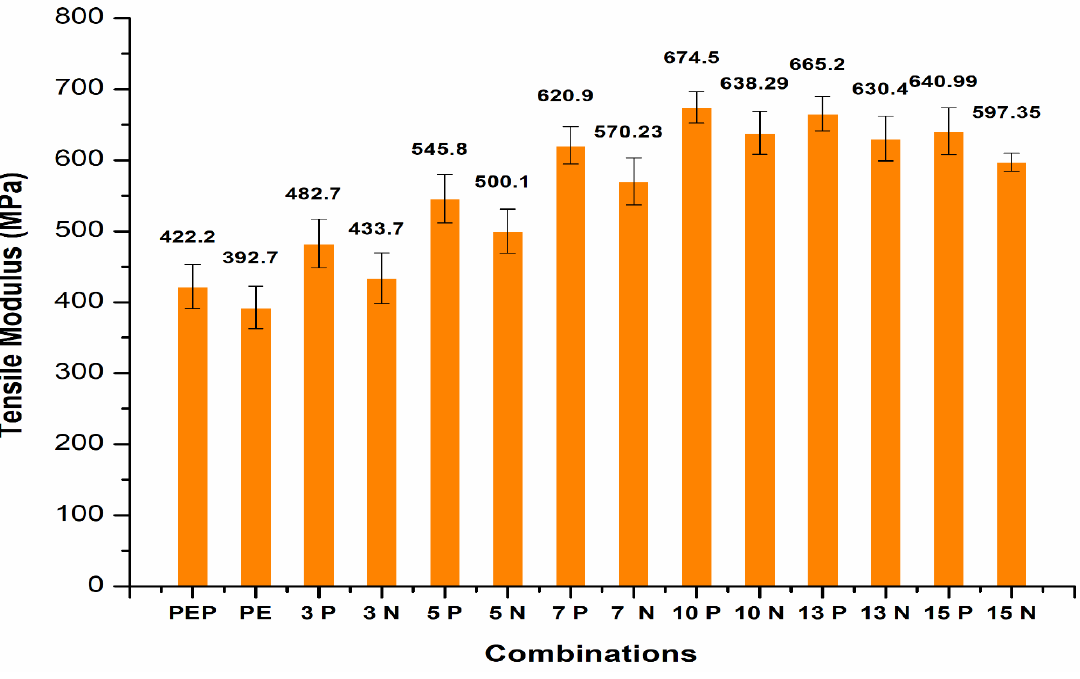
Figure 11. Flexural strength of CF/PE composites.